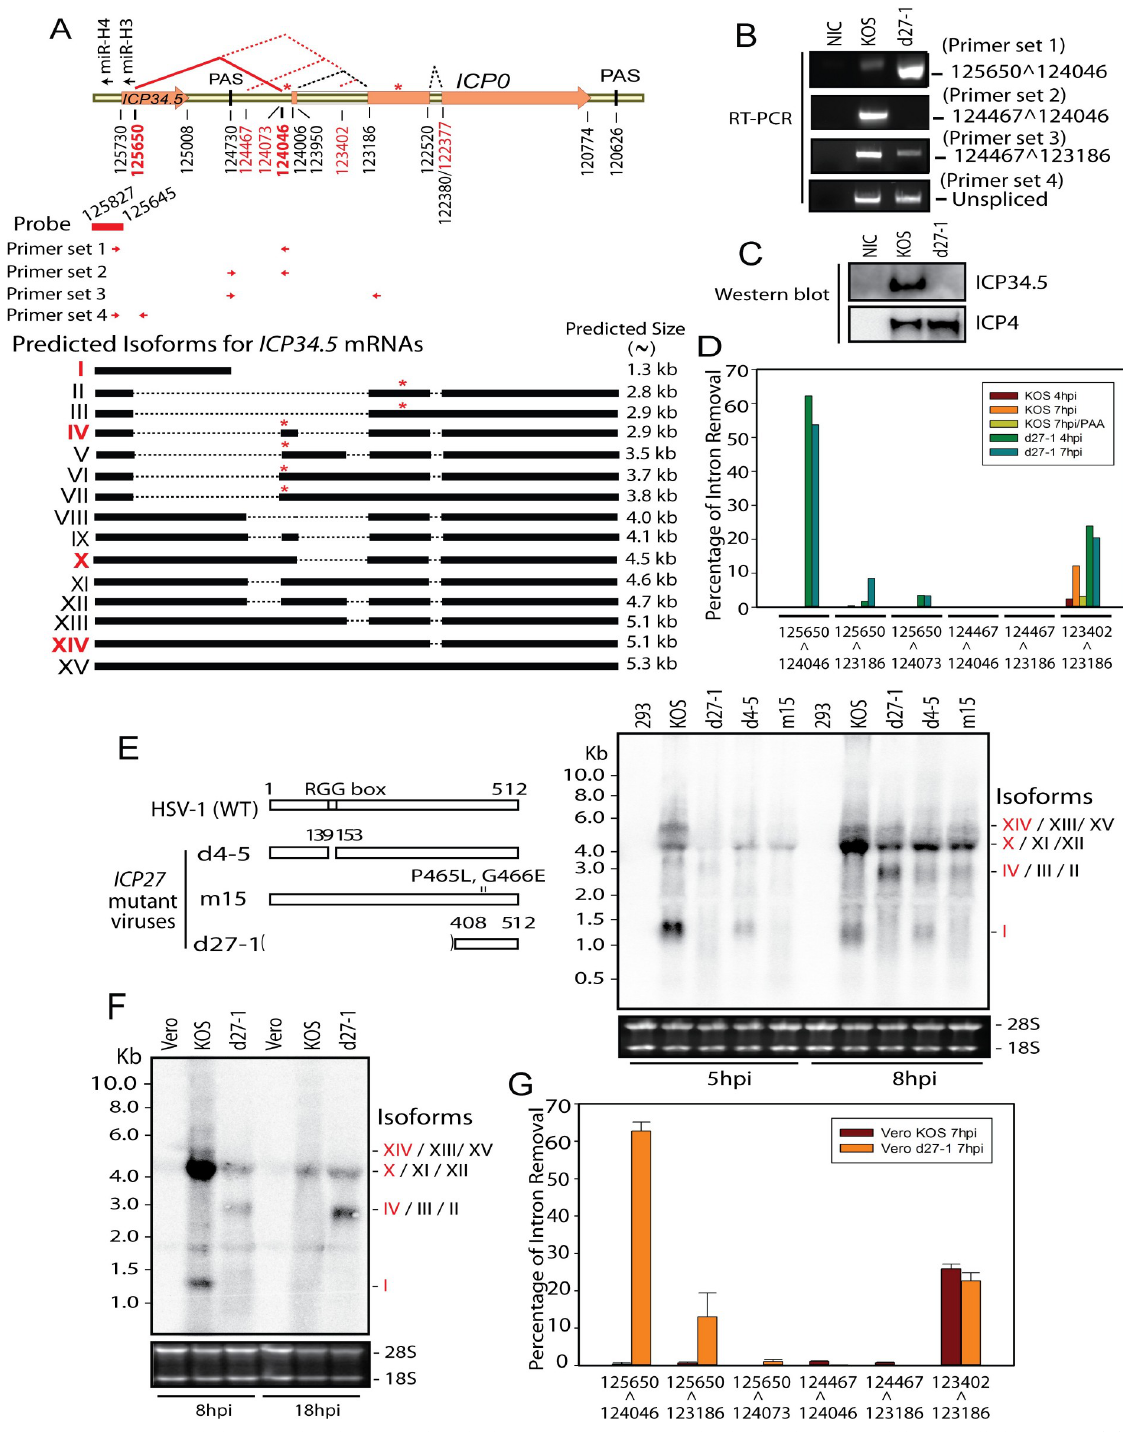
Fig 5. ICP34 . 5 is a novel alternatively spliced gene for which pre-mRNA splicing and polyadenylation is tightly controlled by ICP27. ( A ) Diagram of the ICP34.5 and ICP0 gene locus. Potential ICP34 . 5 mRNA isoforms I-XV, based on identified splice sites, with primers and probe used to detect them. “ � ” represents pre-mature stop codons in frame with the ICP34 . 5 start codon. Relative locations of two latently expressed viral miRNAs, miR-H3 and miR-H4 [3], also named miR-I homolog and miR-LAT-ICP34.5 [2], are labeled on top of the diagram. Novel splice site positions are numbered in red and major novel splice sites (determined by the results presented below) are shown in bold red. ( B ) Confirmation of novel splice junctions mapping to the ICP34 . 5-ICP0 region. cDNAs were prepared from total RNAs from HEK-293